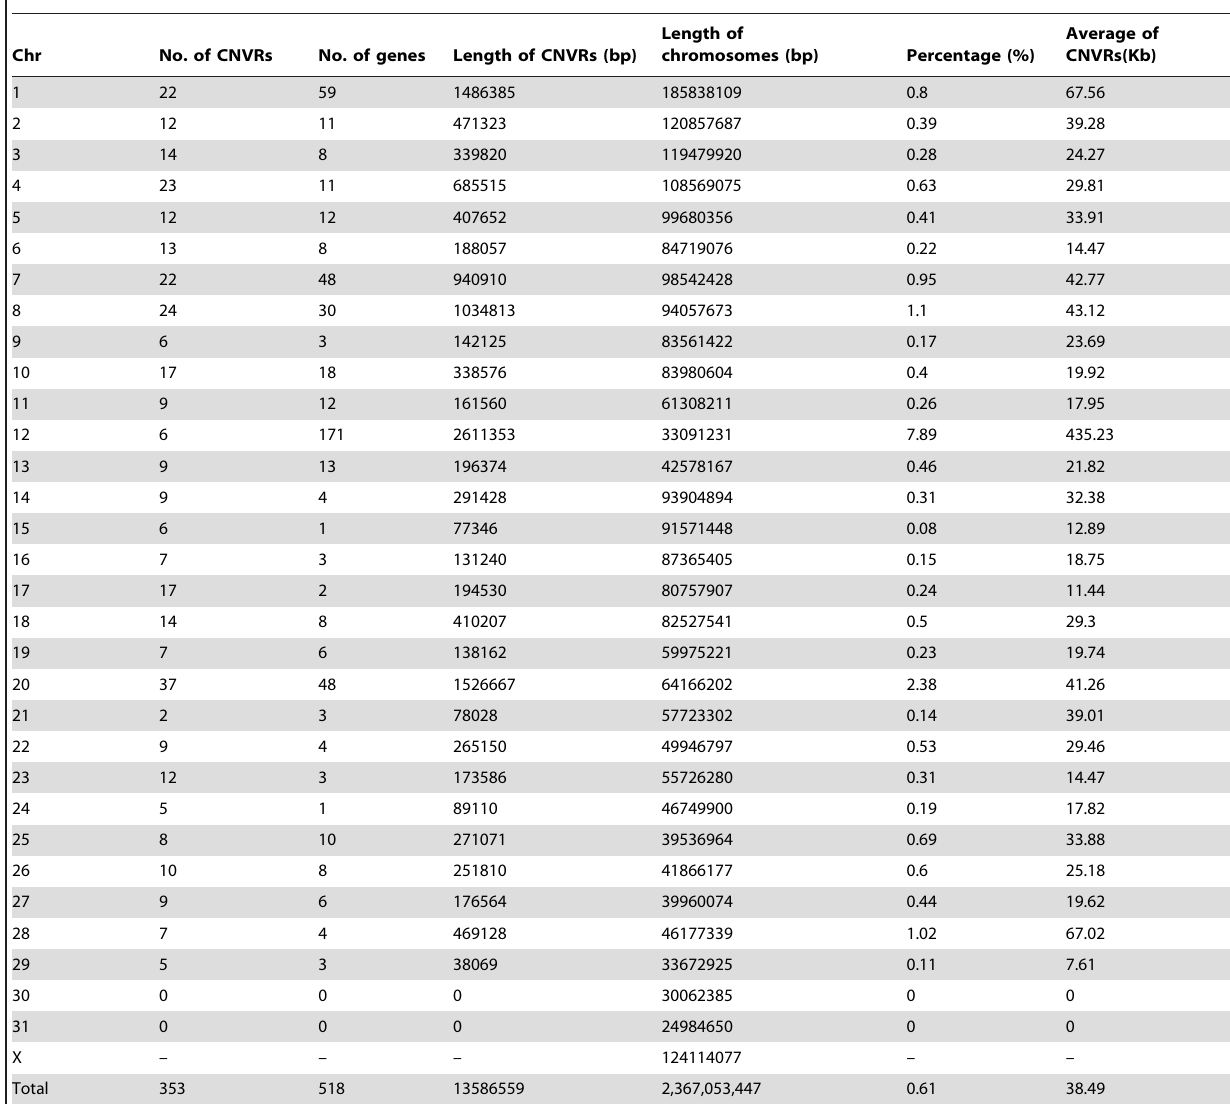
Table 2. Chromosome distribution of CNVRs in horses.